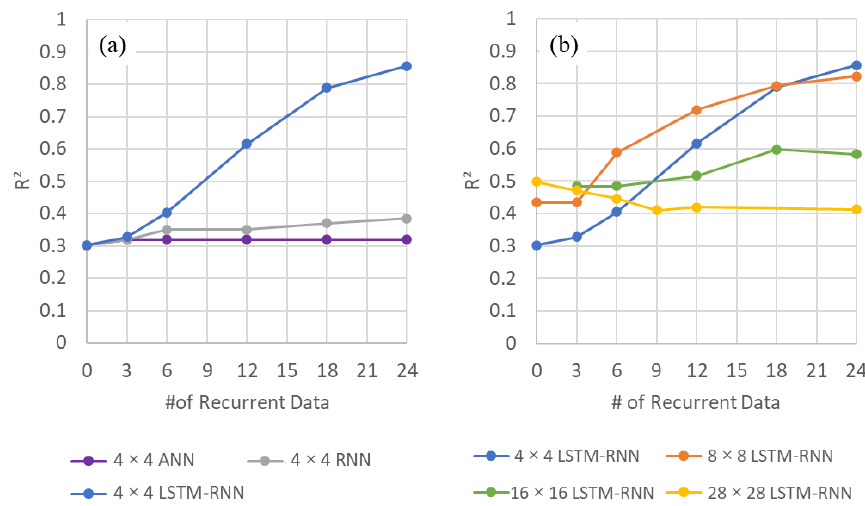
Figure 6. Performance comparison of ( a ) ANN, RNN, and LSTM-RNN; ( b ) spatial optimization results on four variations of input extents: 4 × 4, 8 × 8, 16 × 16, and 28 × 28.